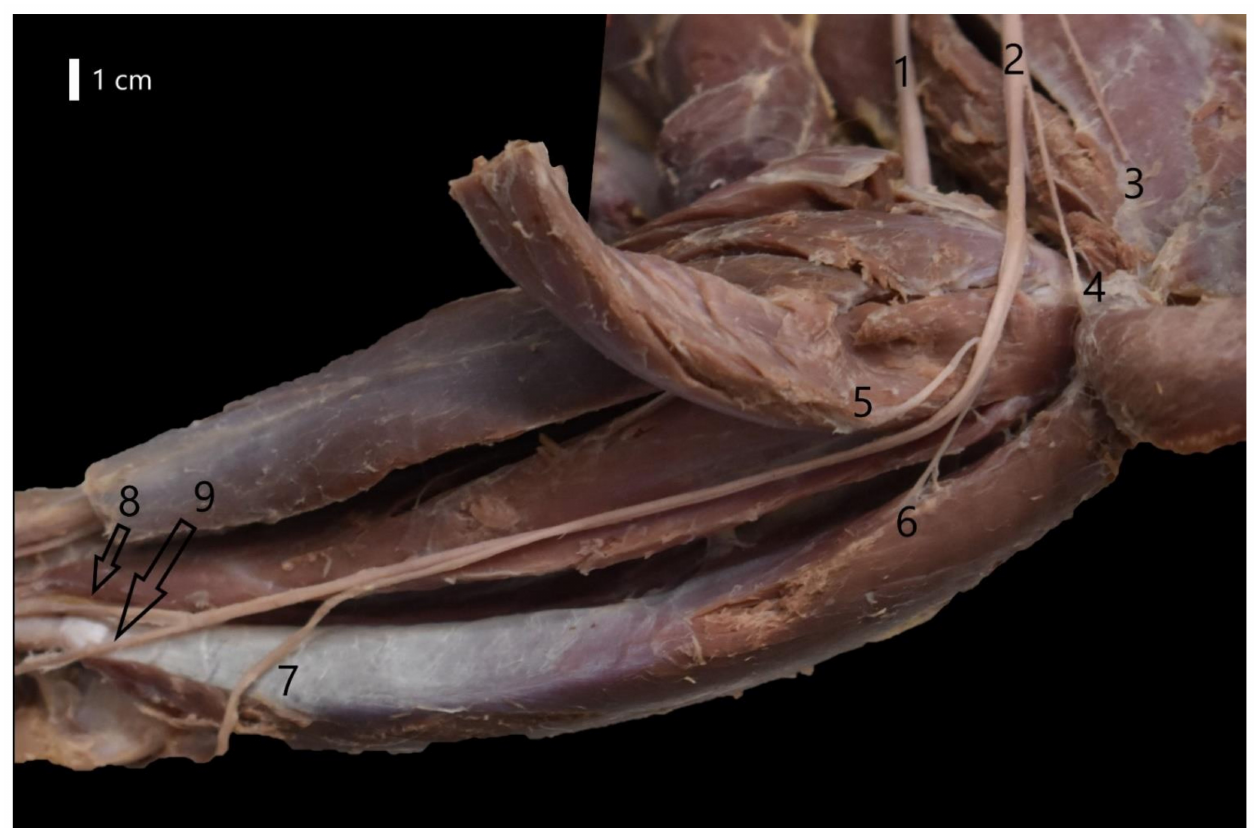
Figure 4. Course of the ulnar nerve at the forearm level in the European badger (Meles meles). 1—Median nerve; 2—Ulnar nerve; 3—Part of the caudal antebrachial cutaneus nerve; 4—Brach of the ulnar nerve to ulnar head of the flexor carpi ulnaris muscle; 5—Branch of the ulnar nerve to humeral head of the flexor digitorum profundus muscle; 6—Branch of the ulnar nerve to humeral head of the flexor carpi ulnaris muscle; 7—Dorsal branch of the ulnar nerve; 8—Superficial branch of the palmar branch of the ulnar nerve; 9—Deep branch of the palmar branch of the ulnar